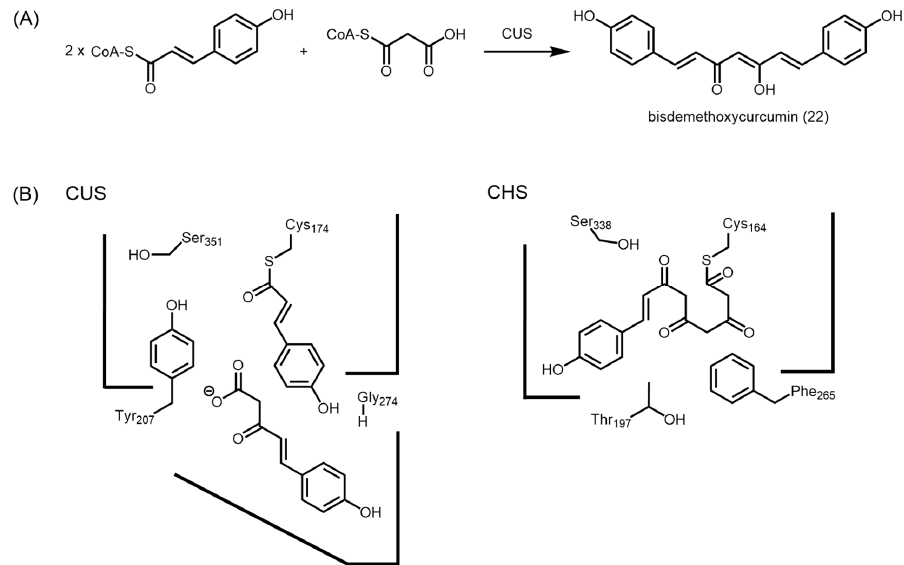
Figure 7. Comparison of the active sites of M. sativa CHS and O. sativa CUS. ( A ) CUS catalyzes the condensation between two units of p -coumaroyl-CoA and one unit of malonyl-CoA to form bisdemethoxycurcumin; ( B ) Schematic representations of the active sites of CUS and CHS. The presence of glycine at position 274 and tyrosine at position 207 orients the active site to allow longer polyketides to be